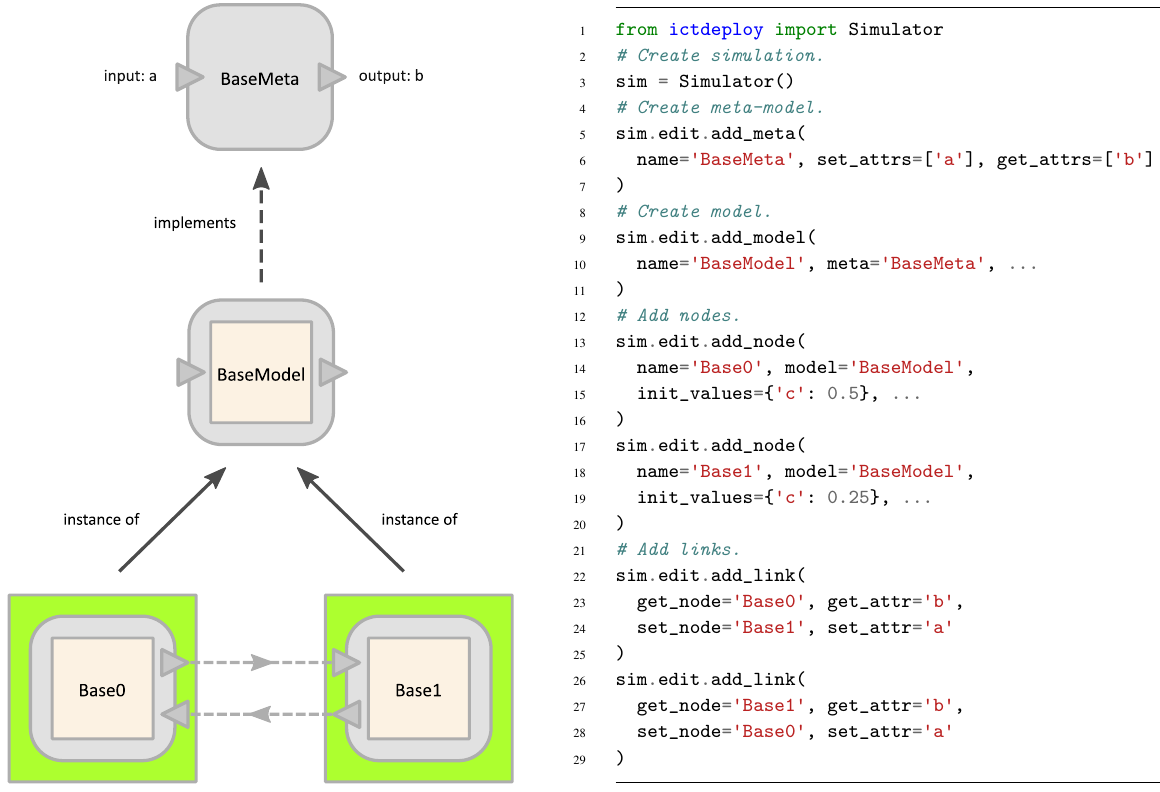
Figure 5. Definition of the simple co-simulation setup